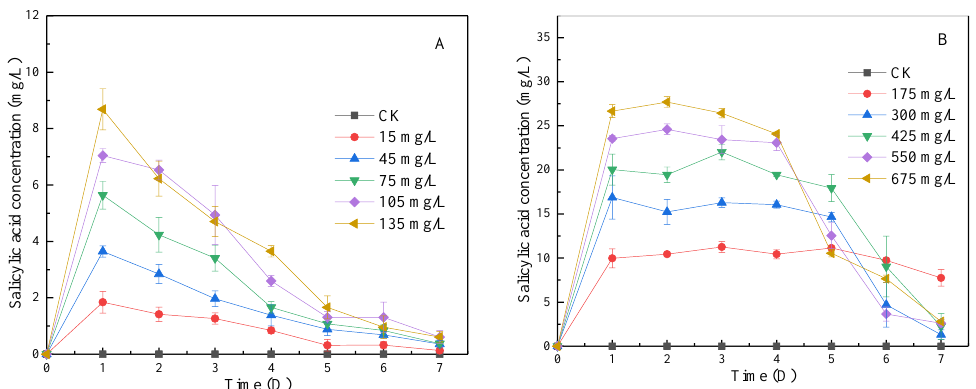
Figure 4. The effect of SA-CS on the concentration of SA in algal liquid at lag phase and log phase: ( A ) the effect of SA-CS on SA at lag phase; ( B ) the effect of SA-CS on SA at log phase.